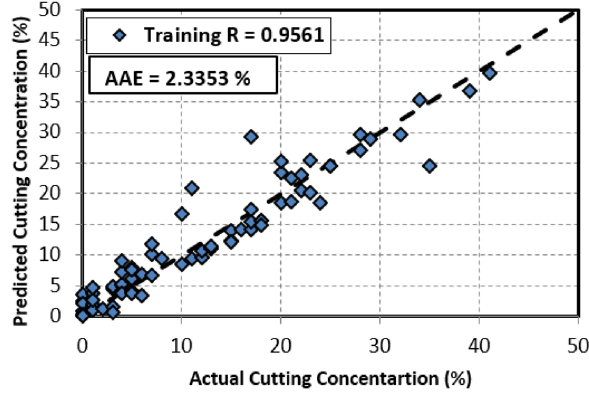
Fig. 11 RBFN-predicted versus actual (experimental) cutting concen- tration from training stage